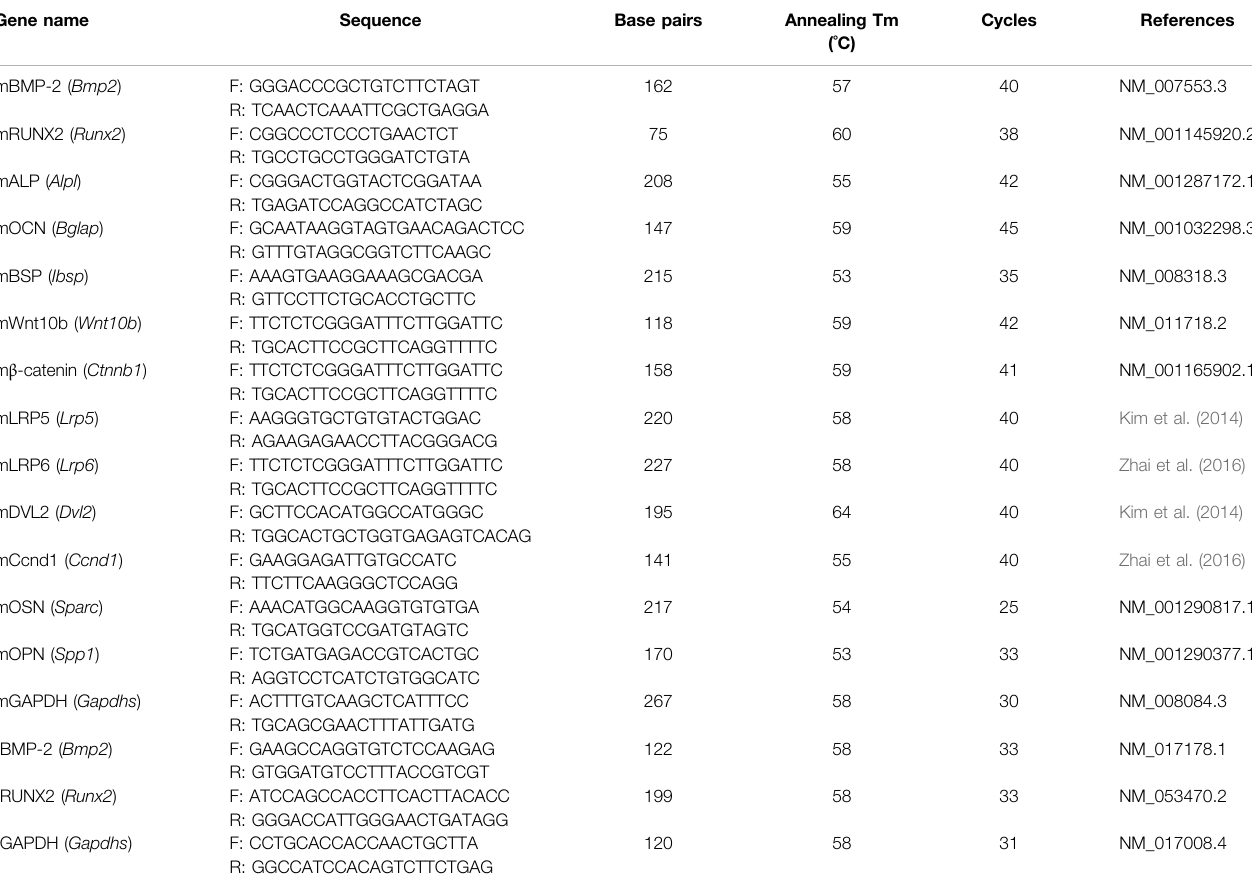
TABLE 1 | Sequences of primers used for reverse transcription